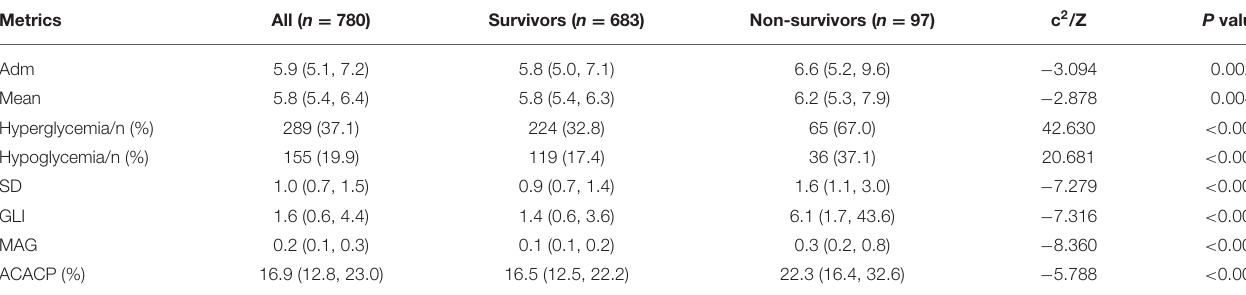
TABLE 2 | The comparison of glucose metrics between survivors and non-survivors [M (P25, P75), n (%)].